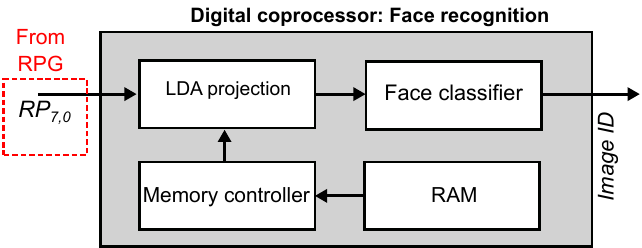
Figure 10. Architecture of the digital coprocessor. The processor receives a stream of RLBPs from the RPG, and simultaneously builds the histogram vector and projects it using LDA. A memory controller retrieves the LDA coefficients from RAM. The Euclidean distance between the projected vector and the contents of database of stored faces is used for classification with the nearest neighbor